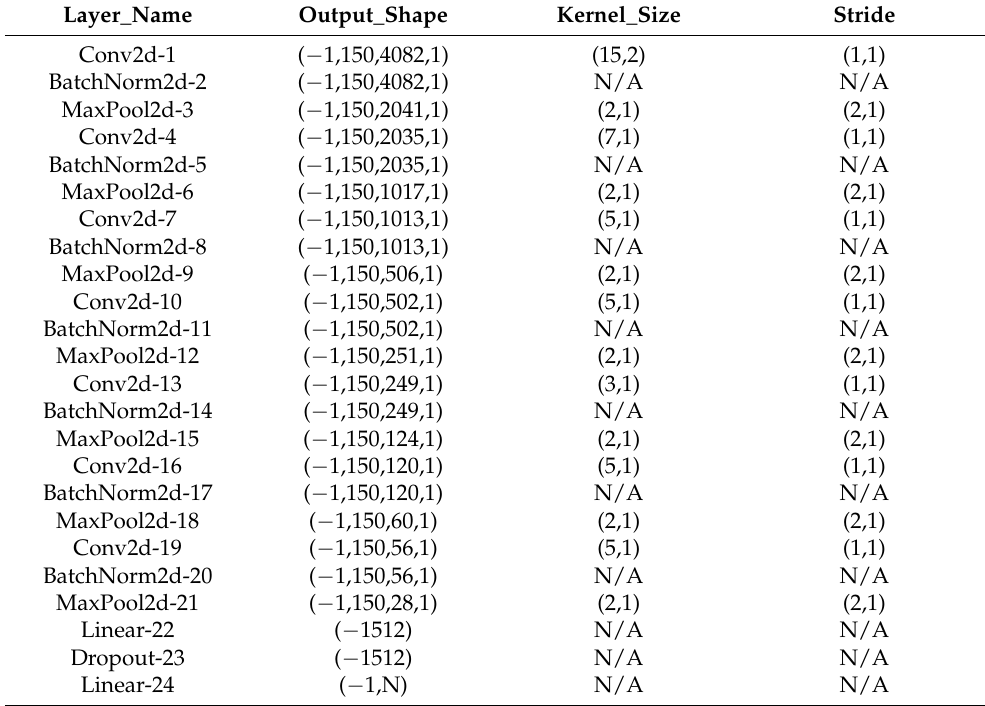
Table 2. The neural network structure